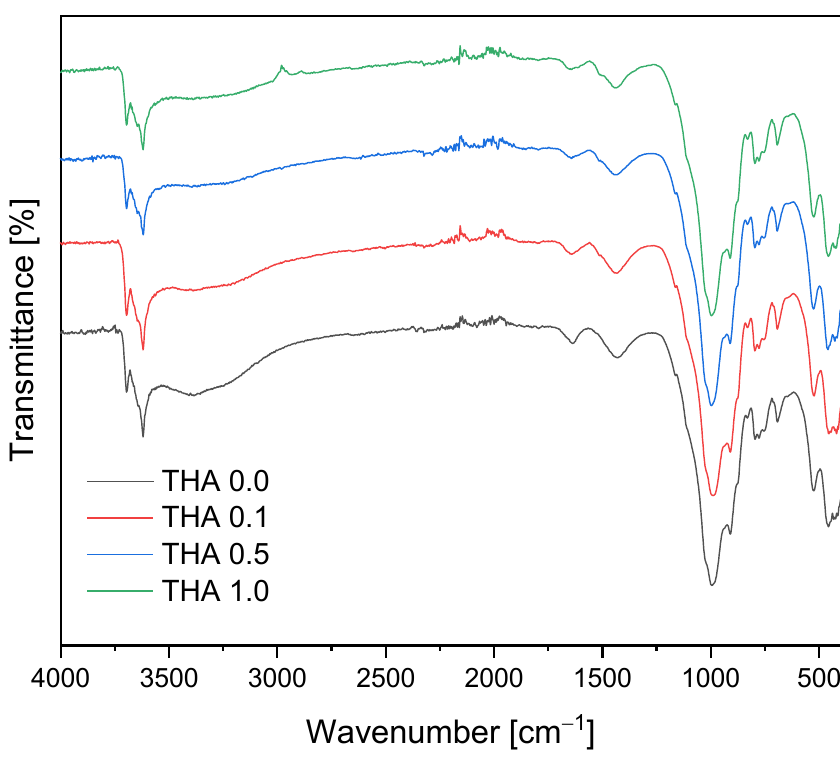
Figure 1. FTIR spectra of raw and modified Figure 1. F TIR spectra of raw and modified illite.